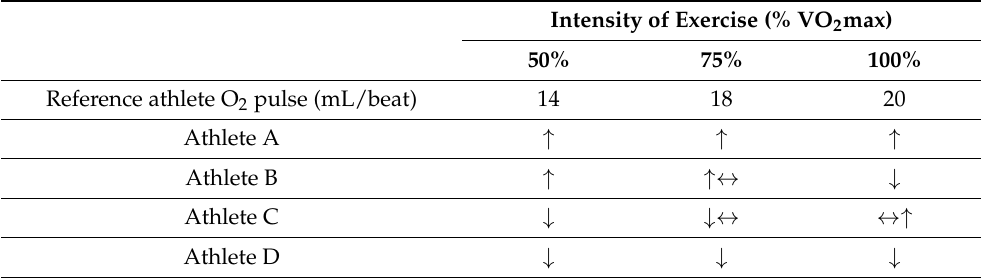
Table 1. O 2 pulse response of four athletes with different adaptation patterns to incremental exercise in comparison with a reference